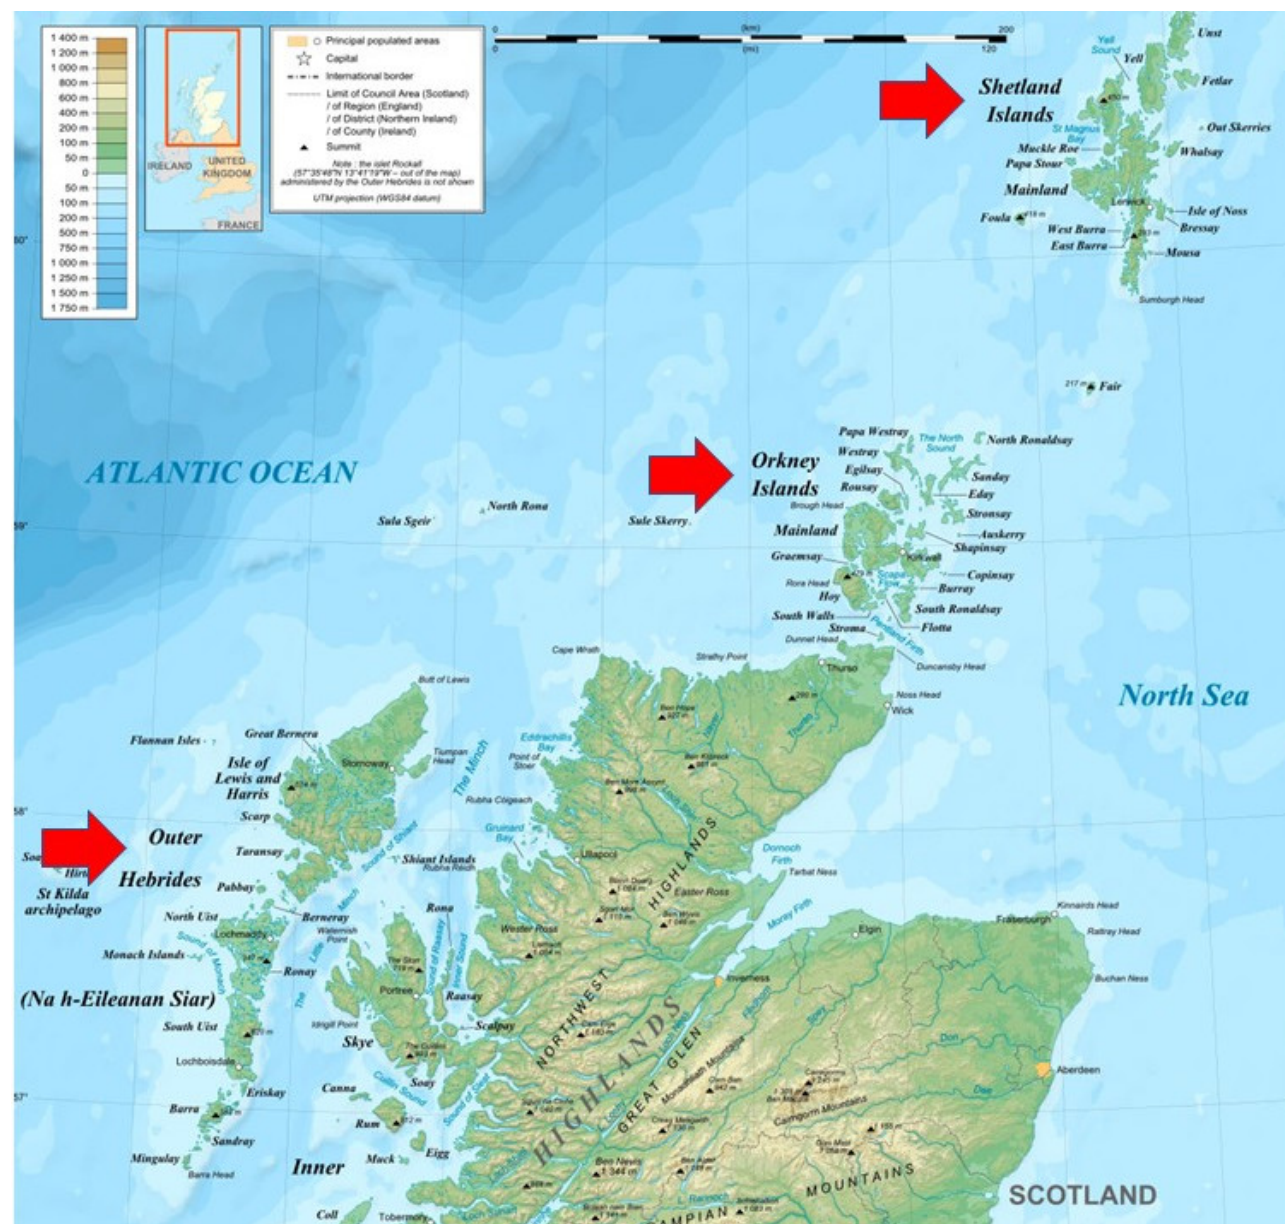
Figure 1. Map of northern Scotland with red arrows showing the location from north to south of the Shetland Isles, Orkney Isles and Outer Hebrides. The image was sourced from Scotland topographic map-en.jpg (2400 × 3450) (wikimedia.org) and originally produced by Eric Gaba; Supplemental Note 1 provides the complete